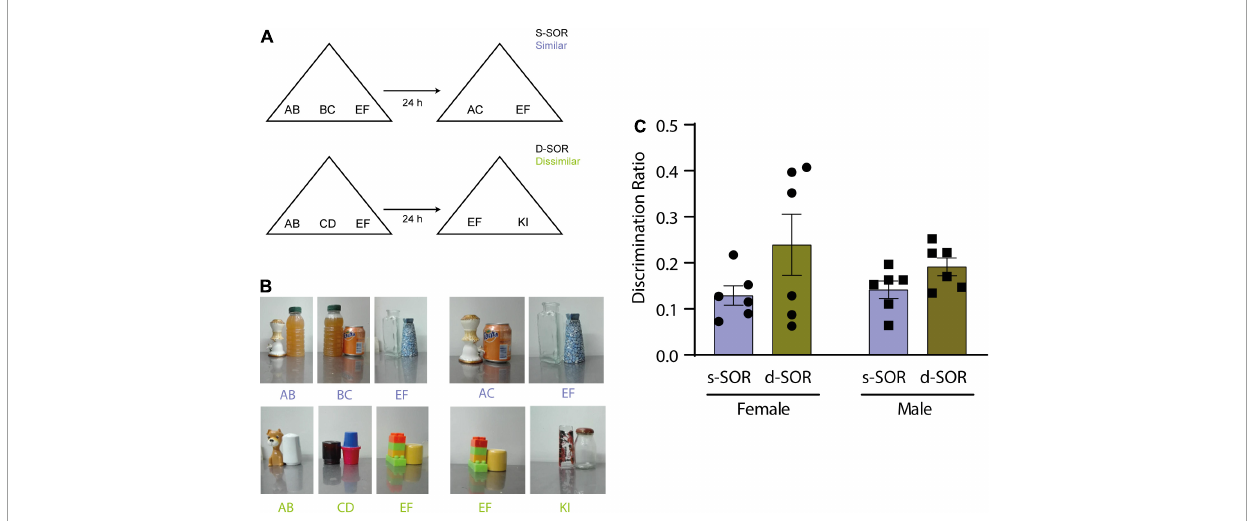
FIGURE1 (A) Diagram of the spontaneous object recognition task (SOR) in the similar version (s-SOR) (top) and the dissimilar version (d-SOR) (up). (B) Examples of a set of objects used in each condition (bottom). (C) Discrimination ratios during the choice phase 24 h after sample phase, in the s-SOR and d-SOR condition in female and male rats. Repeated-measures two-way ANOVA; F = 3.741, pcondition = 0.0819, F = 0.2857, psex = 0.6047, F = 0.5327, pinteraction =